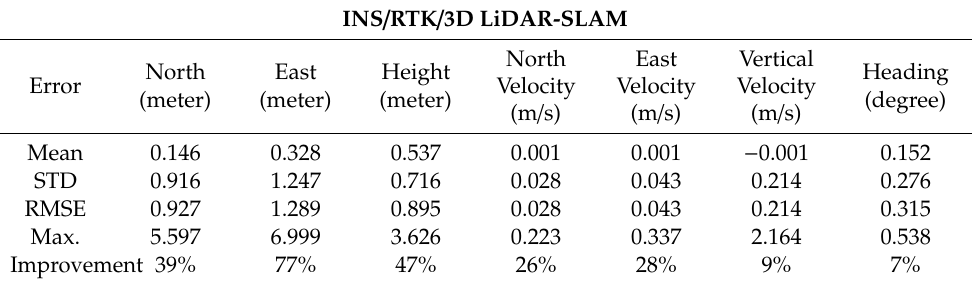
Table 5. Statistical analysis of INS / RTK / 3D